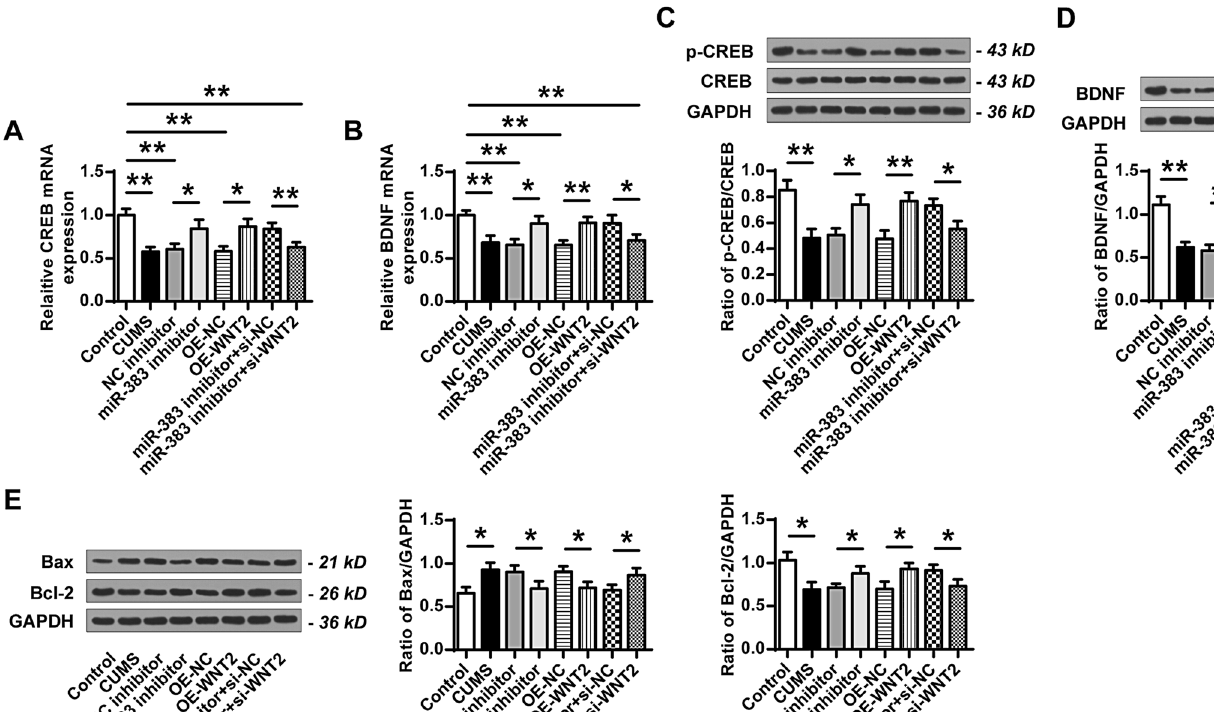
Figure 6. Downregulation of miR-383 or upregulation of Wnt2 increased the expression levels of CREB, BDNF and Bcl-2, while decreased the expression levels of Bax in the hippocampal tissues of CUMS-induced rats. ( A , B ) The mRNA levels of CREB ( A ) and BDNF ( B ) in hippocampal tissues of rats in different groups were evaluated by qRT-PCR. ( C , D ) The protein levels of p-CREB ( C ) and BDNF ( D ) in hippocampal tissues of rats in different groups were evaluated by western blot. ( E ) The protein levels of Bcl-2 and Bax in rat hippocampal tissues of rats in different groups were evaluated by western blot. N = 6. Data were presented as mean ± SD and each experiment was repeated three times. * P < 0.05, ** P <